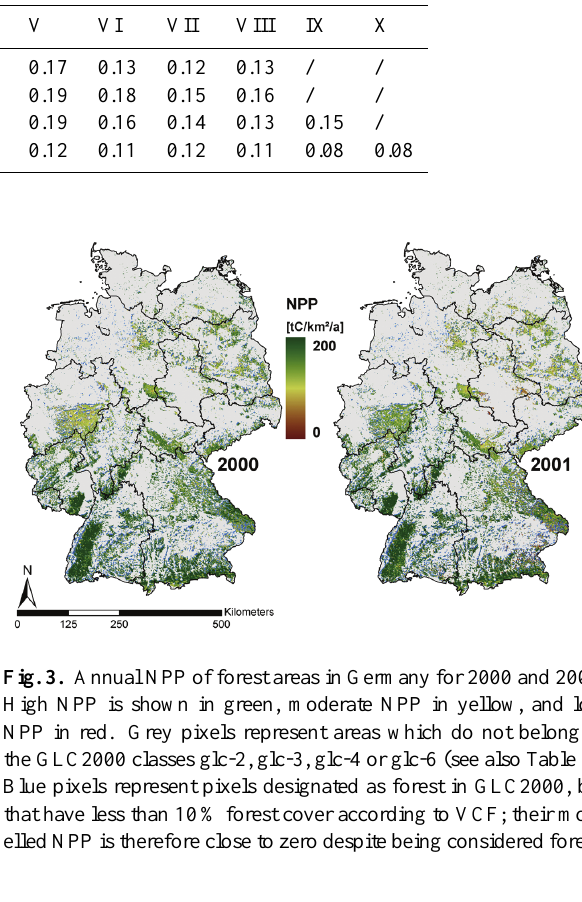
of R for each of the two temperate forest classes modelled by BETHY/DLR (coniferous and deciduous) was calculated (deciduous: 0.19 ± 0.08, coniferous: 0.23 ± 0.04). To